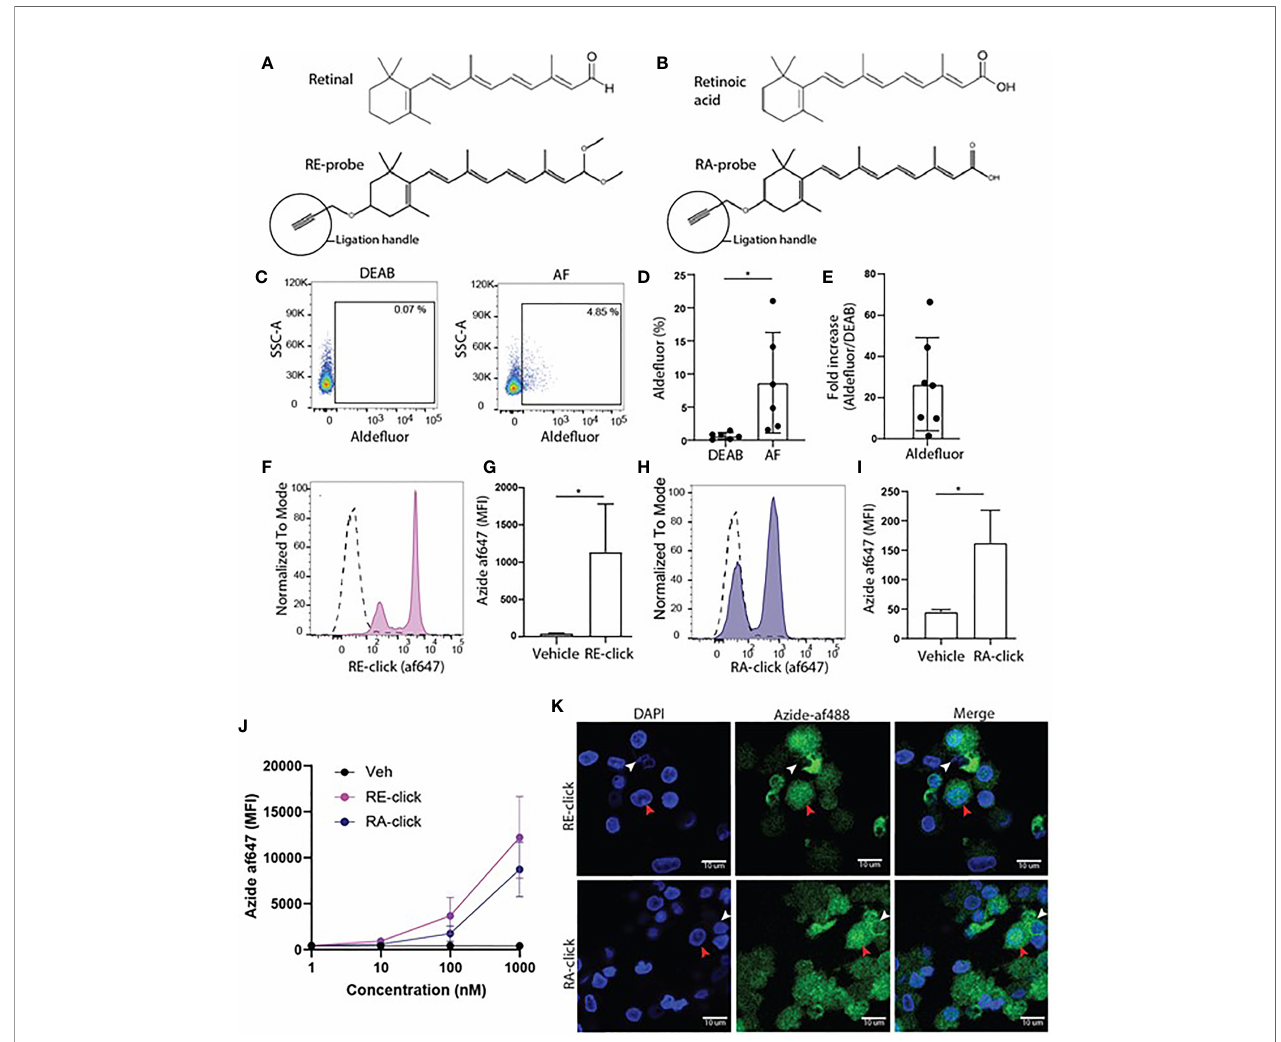
FIGURE 1 | Monocyte-derived dendritic cells have the capacity to take up and metabolize retinoids. (A) Chemical structure of retinal and its synthetic clickable counterpart which contains an alkyne ligation group to allow visualization. (B) Chemical structure of retinoic acid and its synthetic clickable couterpart which contains an alkyne ligation group to allow visualization. (C – K) Monocytes were isolated from blood and differentiated into monocyte-derived dendritic cells (moDCs) during 7 days of culture in the presence of GM-CSF and IL-4. (C) Representative dot plots of aldeluor positivity in moDCs and DEAB-treated negative control. (D) Quanti fi cation of the alde fl uor positivity in moDCs from 6 different donors. (E) Quanti fi cation of the increase of alde fl uor positivity in moDCs compared to the paired DEAB control from 7 different donors. (F – K) Clickable retinoid probes were incubated for one hour in RPMI at 37°C with differentiated moDCs. (F) Representative histogram of the uptake of RE-click (pink) compared to the vehicle control (dotted line) in moDCs. (G) Quanti fi cation of the uptake RE-click compared to the vehicle control in moDCs from 3 different donors. (H) Representative histogram of the uptake of RA-click (blue) compared to the vehicle control (dotted line) in moDCs. (I) Quanti fi cation of the uptake of RA-click compared to the vehicle control in moDCs from 4 different donors. (J) Differentiated moDCs were incubated with multiple concentrations of RE and RA-click ranging from 1000 to 1 nM. Quanti fi cation of the uptake of the clickable probes was detemtined using fl ow cytometry using blood form 3 different donors (K) moDCs were put on a coverslip to assess the spatial distribution of retinoid probes (green) and nuclei (DAPI, blue) using confocal microscopy. White arrow indicates cytoplasmic accumulation, whereas the red arrow indicates nuclear localization. Data are presented as mean± SD. Student's t test; *p <